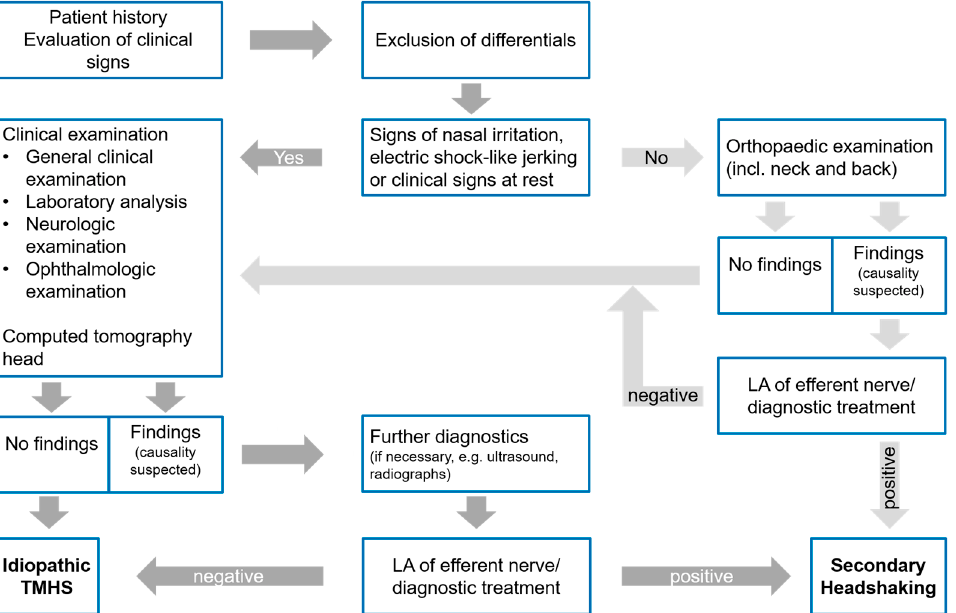
Figure 5. Recommendations for the diagnostic investigation in horses with clinical signs of headshaking. LA: local anaesthesia, TMHS: trigeminal-mediated headshaking.